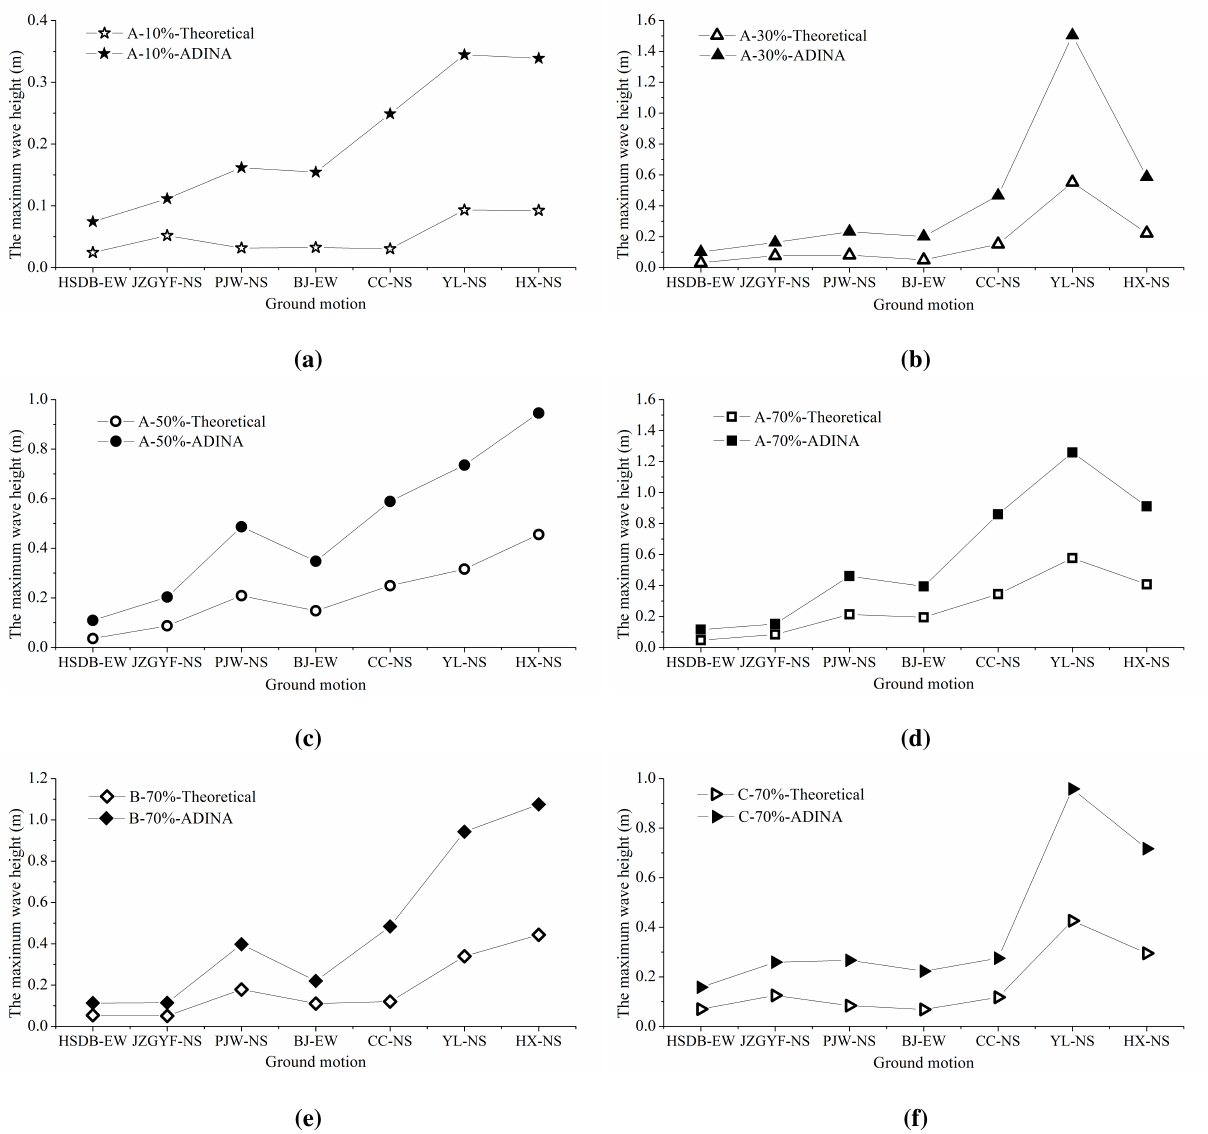
Fig. 5 Theoretical and ADINA calculation results of the maximum sloshing wave height. (a) A-10% condition, (b) A-30% condition, (c) A-50% condition, (d) A-70% condition, (e) B-70% condition and (f) C-70%